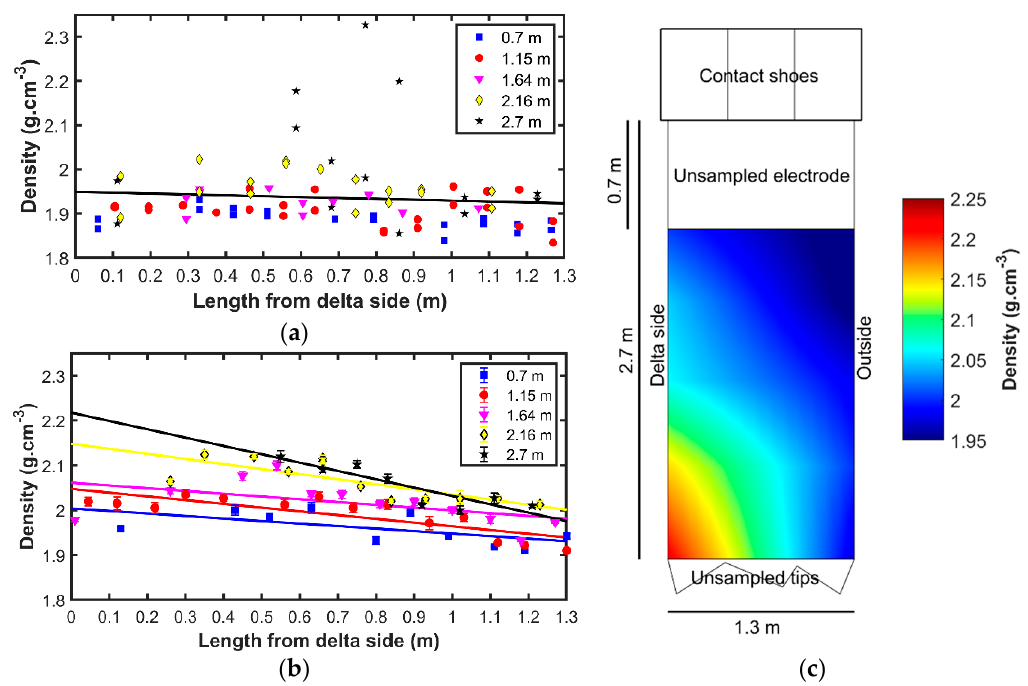
Figure 7. ( a ) ASTM C20-00 average measured bulk densities (markers) as a function of length below the contact shoes and distance from the delta side of the electrode. A single linear fitting of all this data (line) is also indicated; ( b ) gas pycnometry average measured bulk densities (markers) and linear fitting of this data (lines), as a function of length below the contact shoes and distance from the delta side of the electrode; ( c ) 3D rendering of the fitted line data associated with bulk densities at 10 mm intervals across the electrode at each of the lengths below the contacts shoes indicated in Figure 7b.